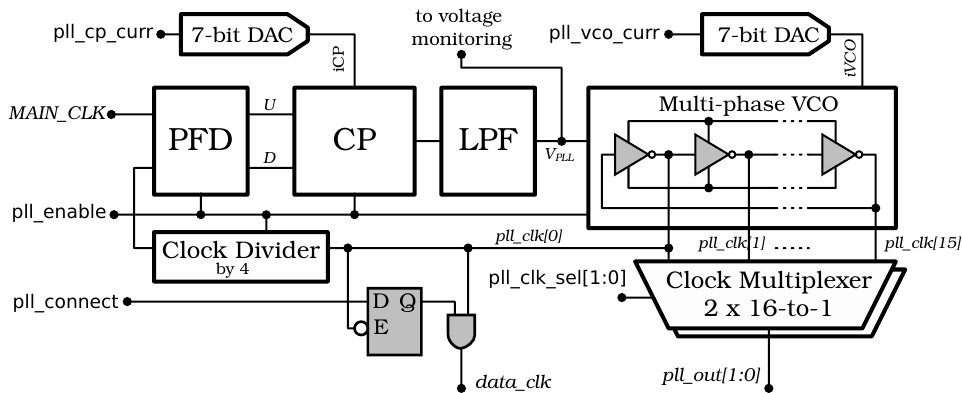
Figure 6. PLL block diagram: PFD—Phase and Frequency Detector, CP—Charge Pump, LPF—Low Pass Filter, VCO—Voltage Controlled